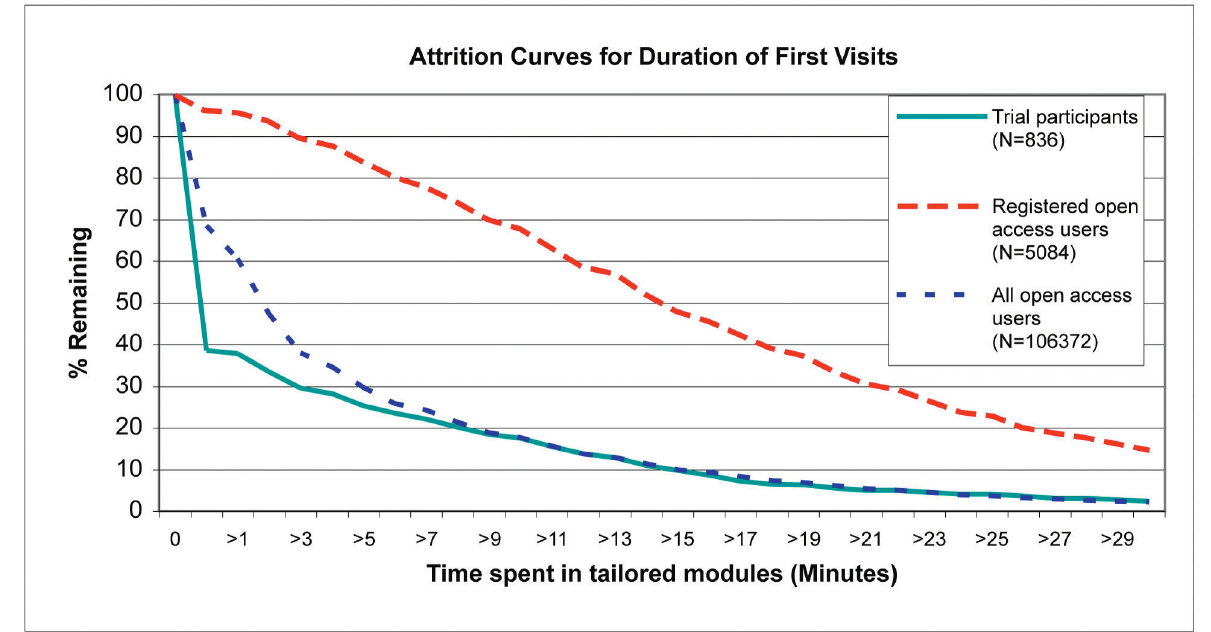
Figure 6 and Figure 7 present attrition curves for the time spent in the tailored modules during the first visit and during the longest visit, respectively, for open access users (all open access users and subgroup of registered open access users only) and for trial participants. Registered open access users spent more time in the tailored modules both during their first visit and during their longest visit compared with all open access users and compared with trial participants. The majority of trial Figure 6. Attrition curves for the duration of the first visit for open access users and trial